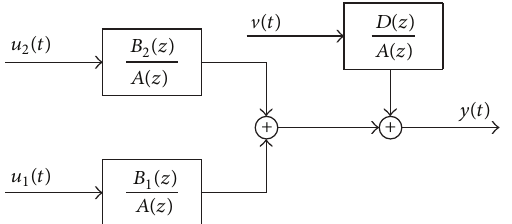
Figure 1: The two-input single-output system with moving average